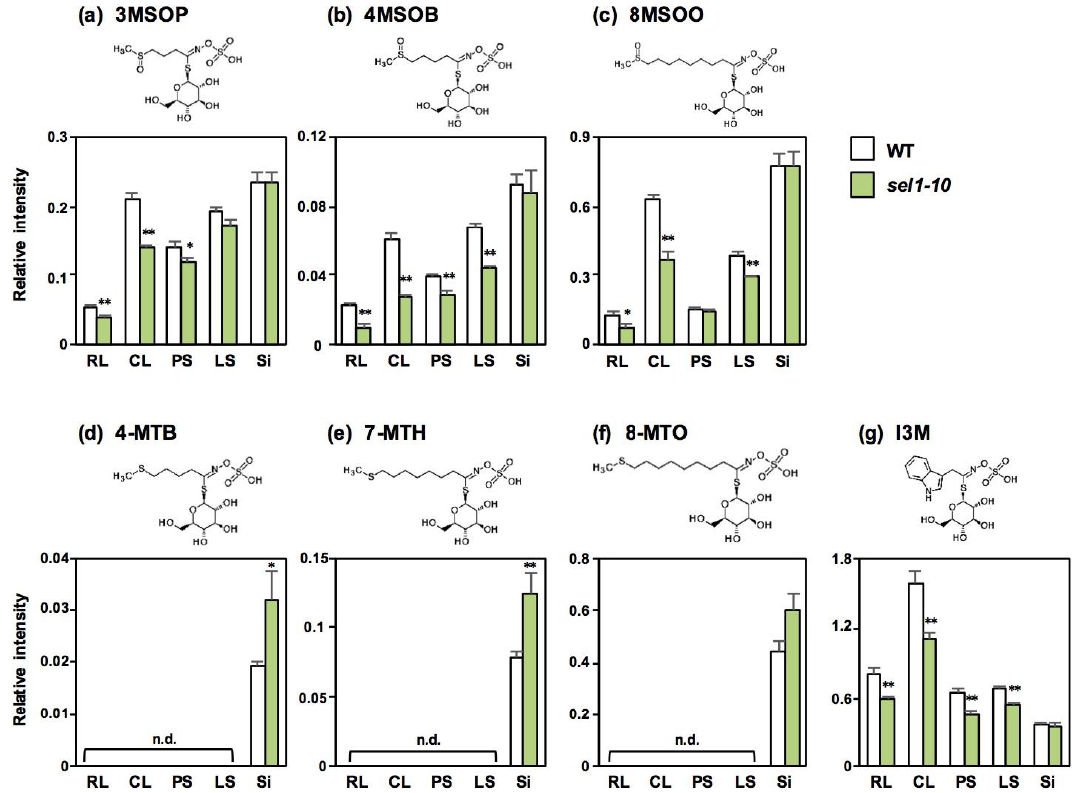
Figure 4. Glucosinolates (GSL) accumulation in different parts of WT and sel1-10 plants . GSL levels in different parts were determined by LC-MS. The relative amount was calculated as the ratio of peak height of each GSL to that of the internal standard (L(+)-10-camphor sulfonic acid) and then divided by the dry weight of the sample. WT and sel1-10 seedlings were grown for 6 weeks in vermiculite, after which, each part was harvested. ( a ) 3-methylsulfinylpropyl GSL (3MSOP), ( b ) 4-methylsulfinylbutyl GSL (4MSOB), ( c ) 8-methylsulfinyloctyl GSL (8MSOO), ( d ) 4-methylthiobutyl GSL (4MTB), ( e ) 7-methylthioheptyl GSL (7MTH), ( f ) 8-methylthiooctyl GSL (8MTO), ( g ) indol-3-ylmethyl GSL (I3M). Rosette leaves (RL), cauline leaves (CL), primary stems (PS), lateral stems (LS), and siliques (Si). White and green bars represent the relative GSL content in WT and sel1-10 plants, respectively. Data are shown as averages with error bars denoting SEM (n = 3). Asterisks indicate significant differences (Student’s t -test; * 0.05 < p <0.1, ** p < 0.05) between WT and sel1-10 plants. n.d., not detected. The chemical structures of the GSLs were obtained from KEGG Databases in DBGET (https://www.genome.jp/dbget/).